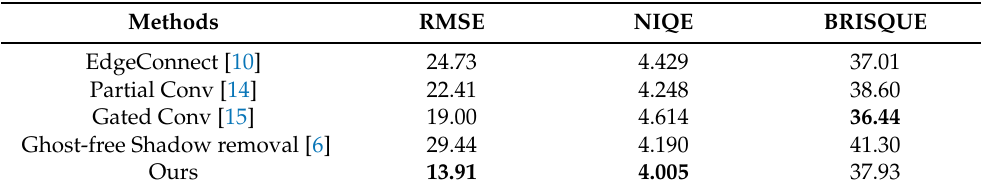
Table 1. Quantitative comparisons of shadow removal in terms of Root Mean Square Error (RMSE), Naturalness Image Quality Evaluator (NIQE), and Blind Referenceless Image Spatial Quality Evalua- tor (BRISQUE).